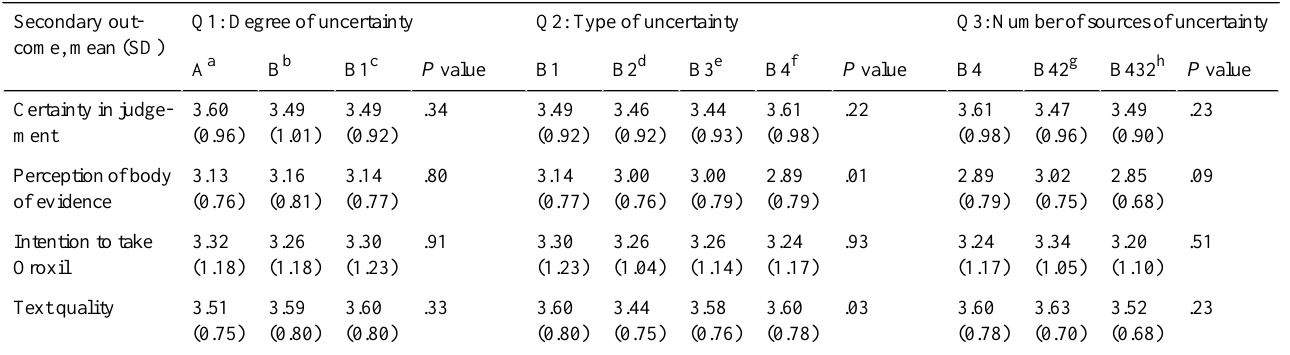
Q3: Number of sources of uncertaintyQ2: Type of uncertaintyQ1: Degree of uncertainty Secondary out-